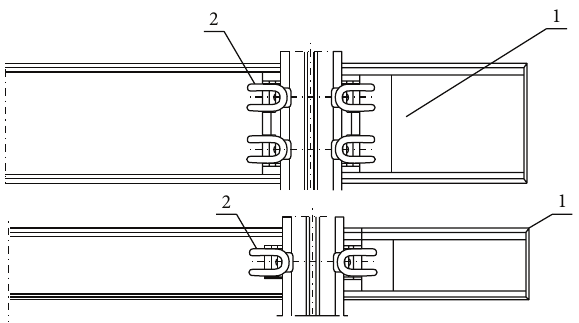
Figure 3: Two kinds of sleepers with different fastening systems.